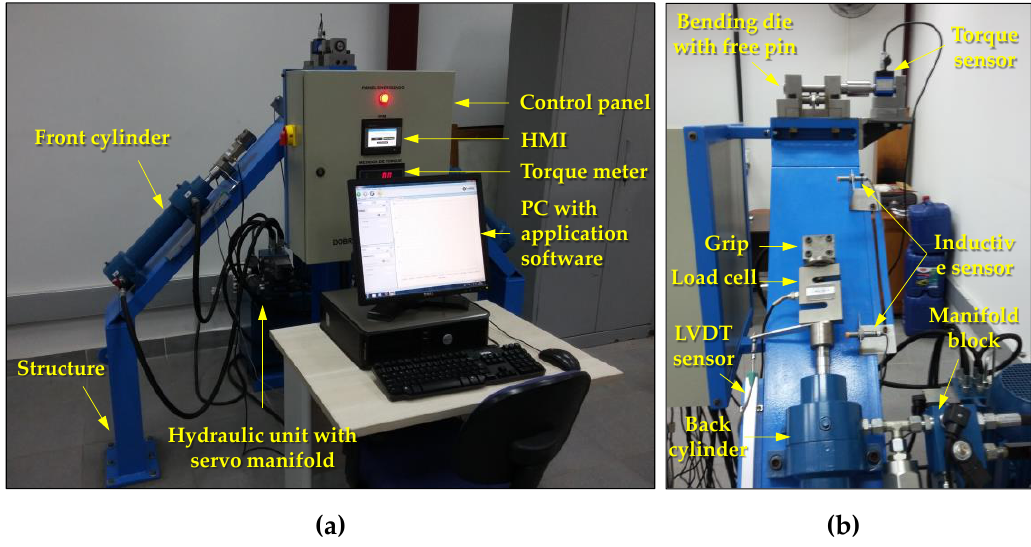
Figure 4. Tribo-simulator of metallic sheets: image ( a ) front and ( b ) side.